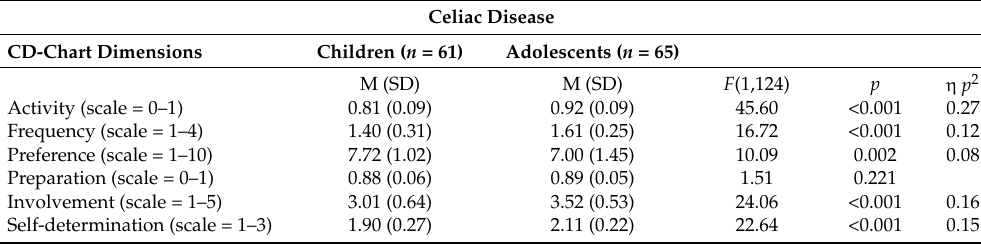
Table 4. Comparison of means and standard deviations of six CD-Chart dimensions between children (8–11) and adolescents (12–18) with CD.